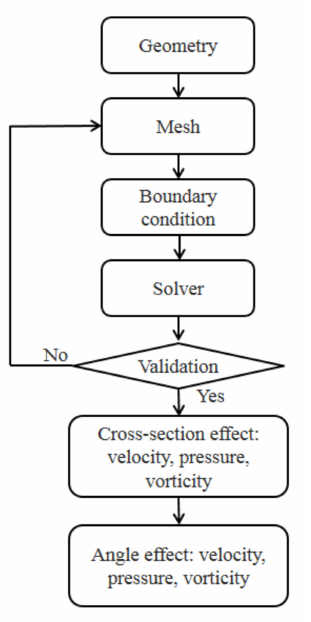
Figure 2. The method workflow of the